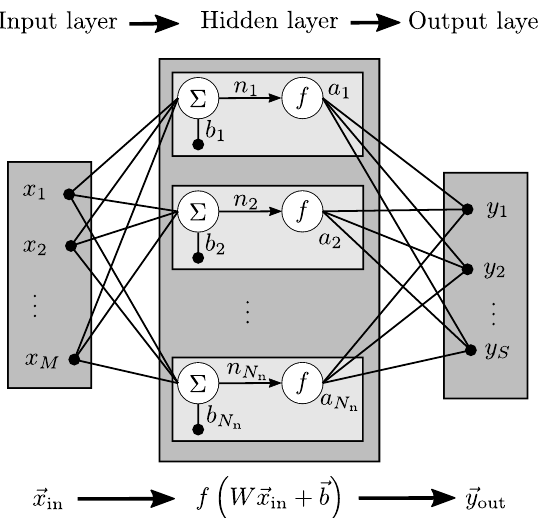
Figure 2. Artificial neural network structure with one hidden layer and multiple